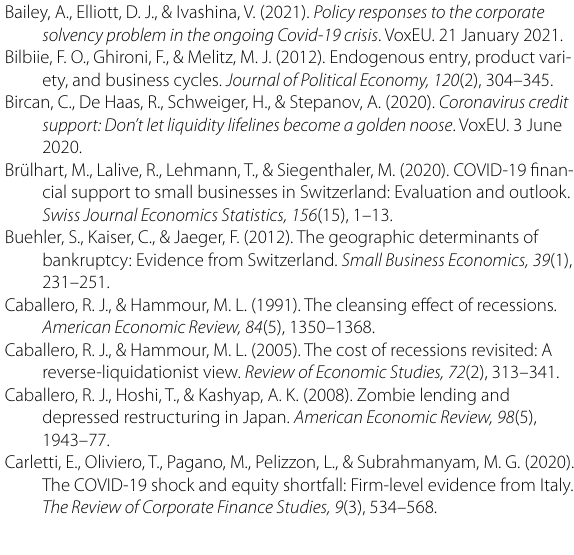
Fig. 23 Regional start-up rates before and after start of COVID-19. Notes : The figure shows the monthly start-up rate ( adjusted frequency of new firm formations divided by the stock of firms) in the Swiss greater regions before and after the start of the COVID-19 crisis as compared to the start-up rate in the respective rest of the economy. The last month before the crisis start ( dotted lines are the average bankruptcy rates over the 22 months before or after the crisis